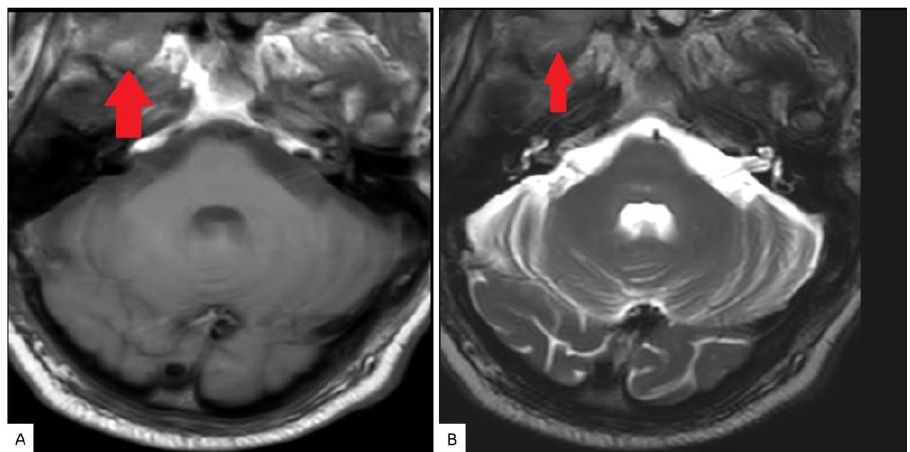
Figure 2. Frontal view radiograph of the right femur demonstrating a 10 cm in length lytic lesion of the proximal half of the femoral diaphysis (solid arrow), with a smaller lesion more proximally (open arrow).